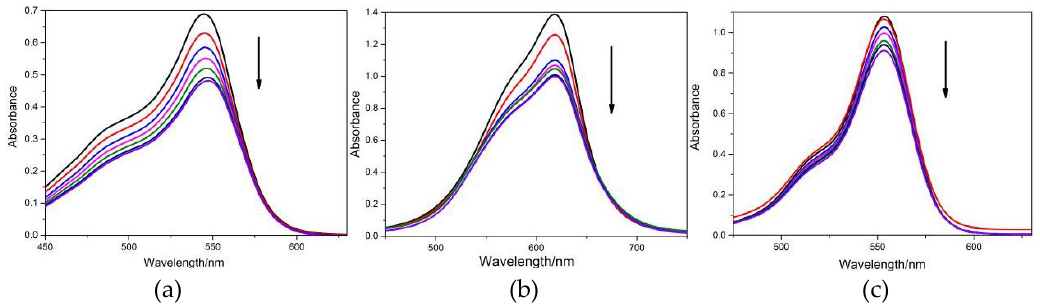
Figure 8. The absorption spectra of ( a ) FB, ( b ) BR2 and ( c ) VBB under different concentrations of CT-DNA. The arrows indicate the spectra change of dyes with the addition of CT-DNA at different concentrations for 0 ( — ), 4 ( — ), 8( — ), 12 ( — ), 16 ( — ), 20 ( — ), and 24 ( — ) µ M. ( n = 3).